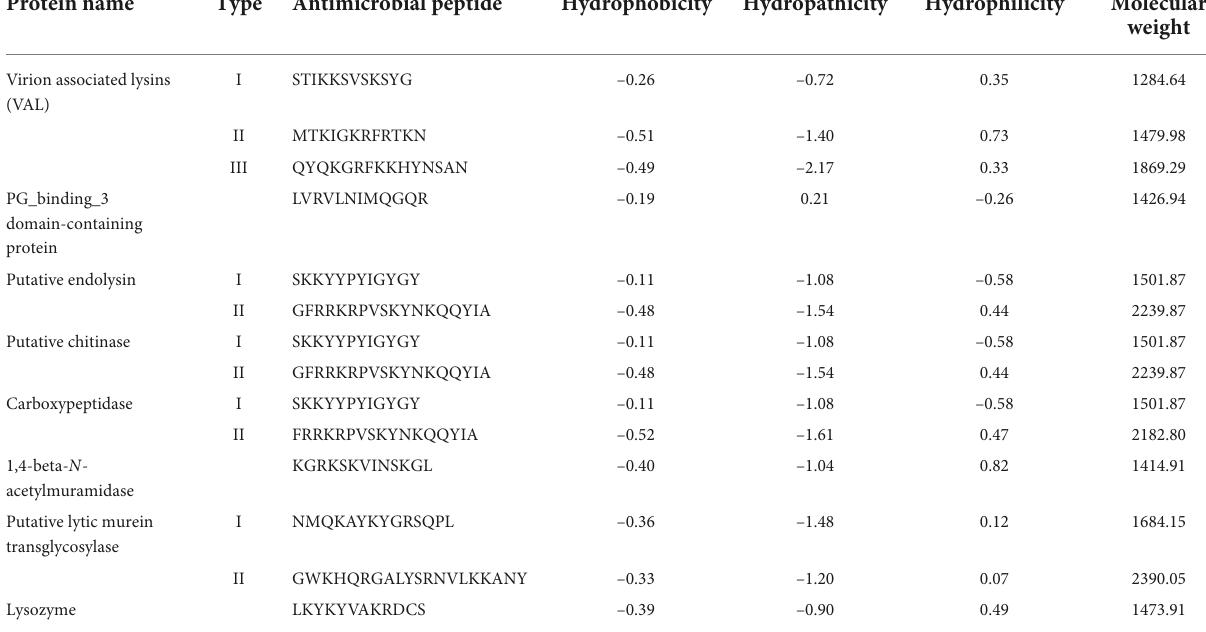
TABLE 4 Physiochemical properties of the antimicrobial